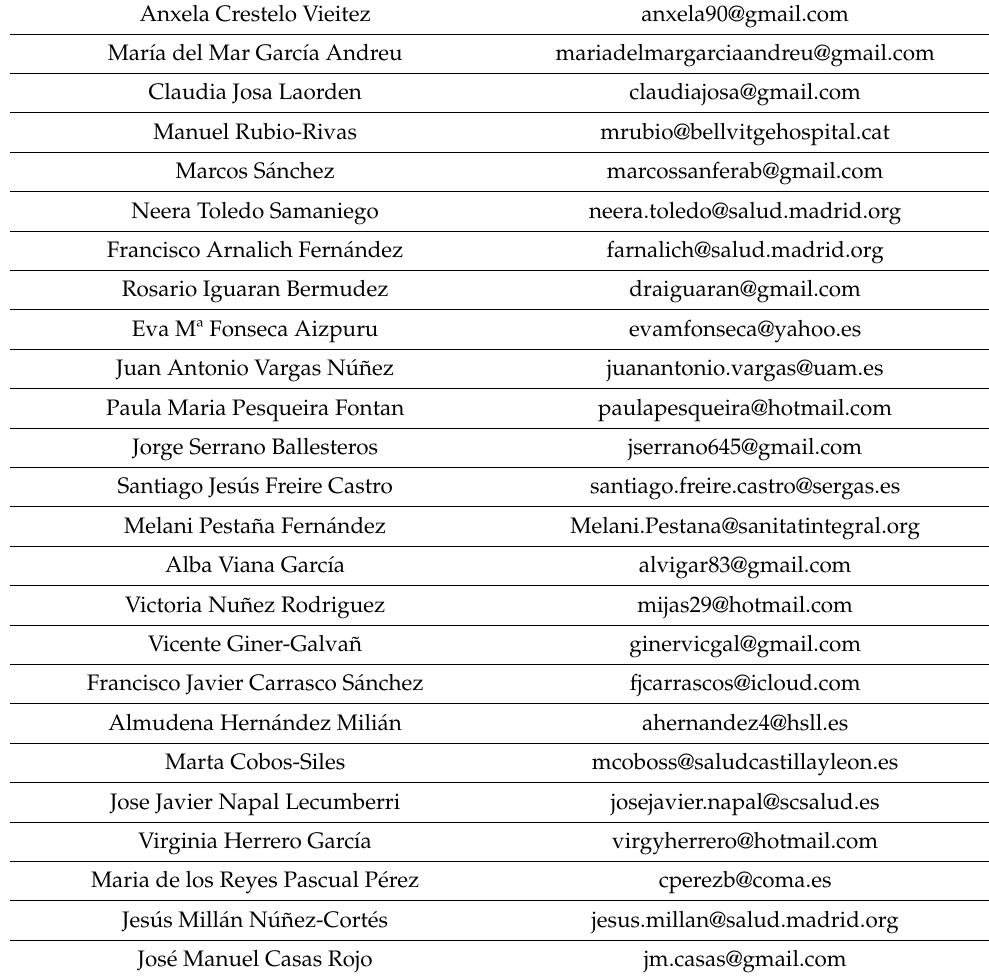
Table A1. List of the SEMI-COVID-19 Network